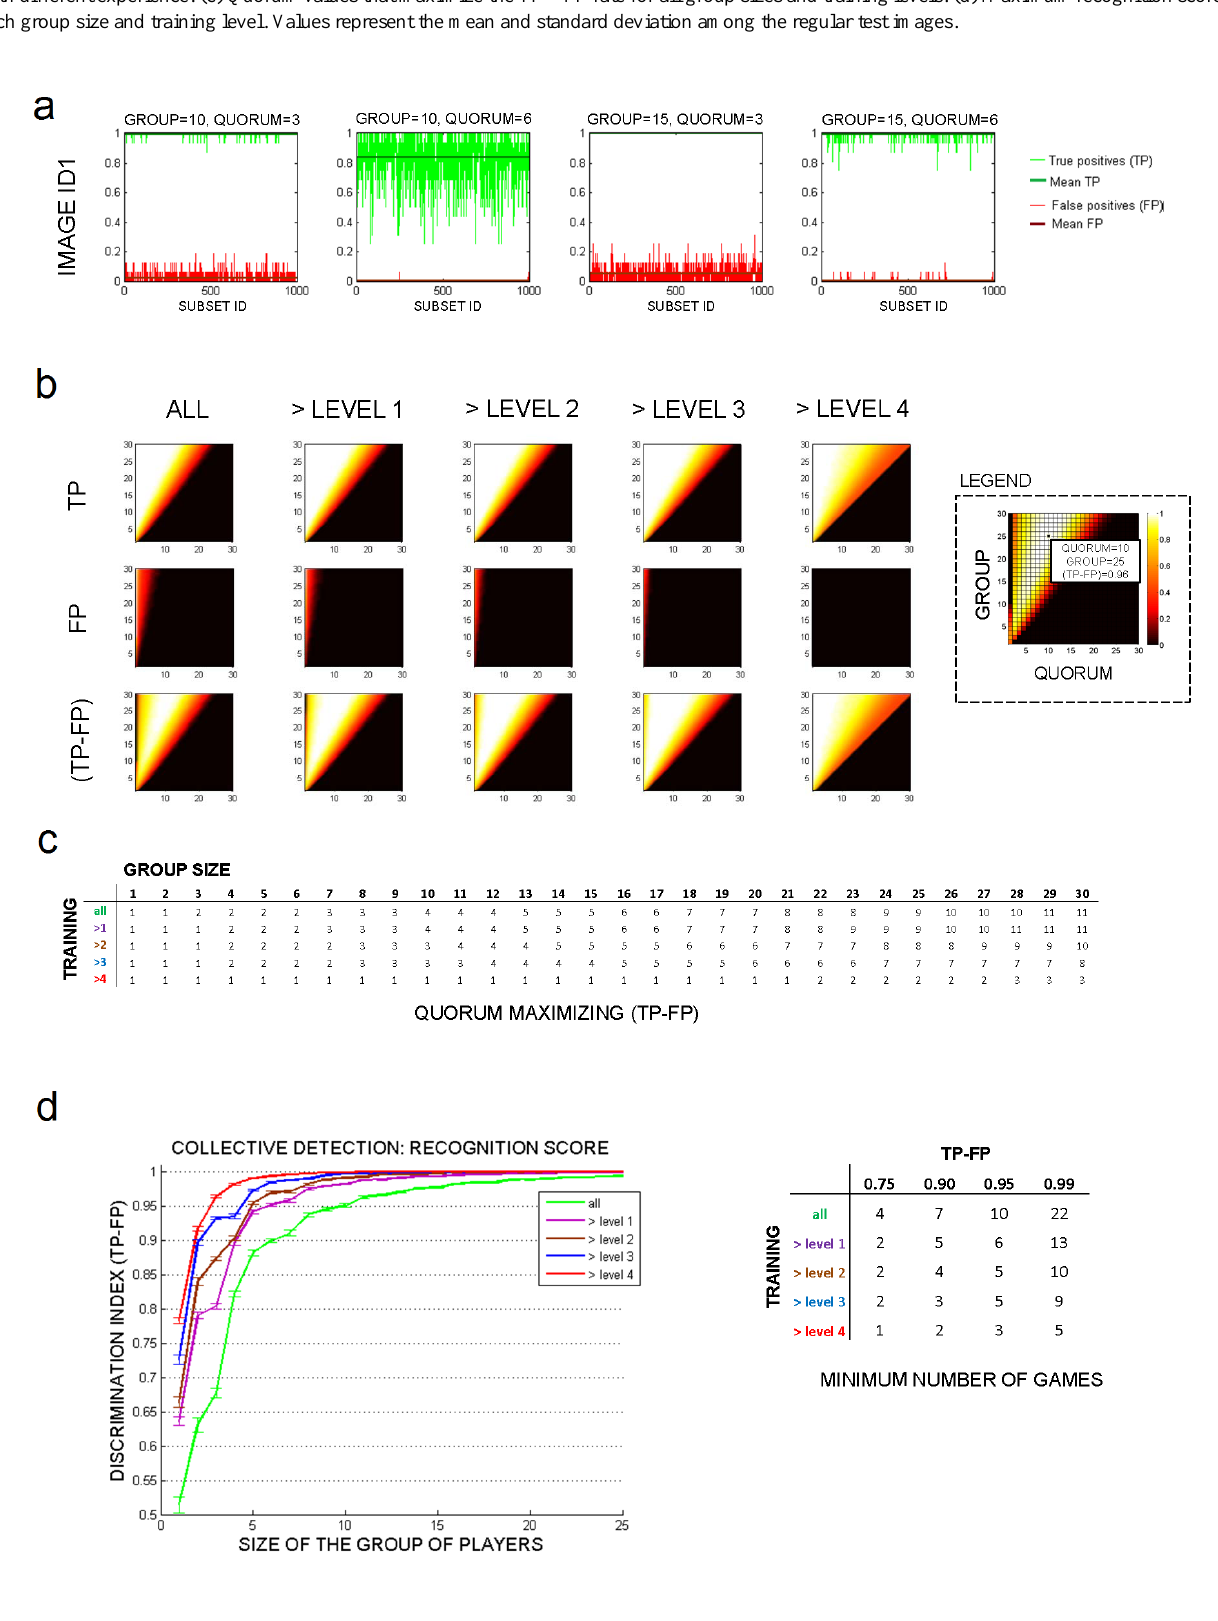
Figure 5. Collective parasite detection. (a) Accuracy results in 1000 random groups run over image ID1 with a group of 10 and 15 games and a quorum of 3 and 6 votes. (b) Mean results of true positives (TP), false positives (FP), and TP – FP for 1000 experiments of all the group sizes and quorum values with different experience. (c) Quorum values that maximize the TP – FP rate for all group sizes and training levels. (d) Maximum recognition score for each group size and training level. Values represent the mean and standard deviation among the regular test